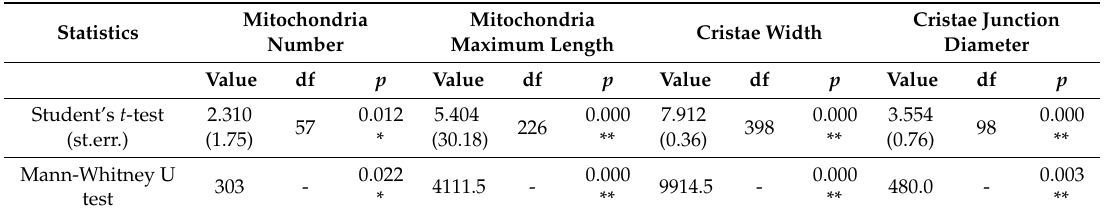
Table 3. Student’s t -test and Mann-Whitney’s test for mitochondria number, maximum length, cristae width, and cristae junction diameter in controls (CT) and ovarian cancer (OC).